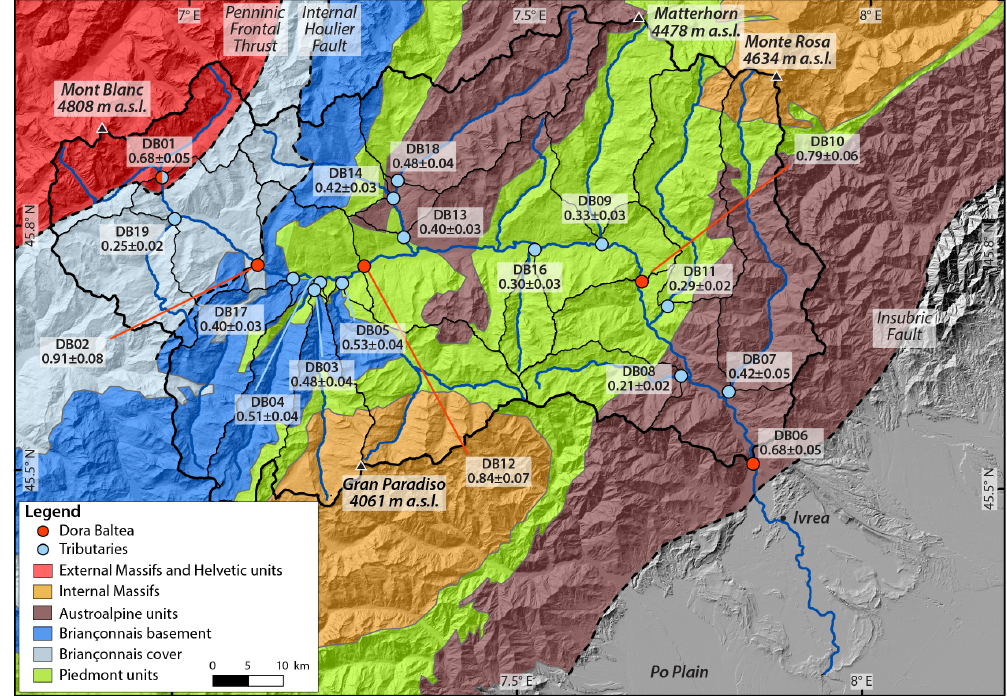
Figure 2. Simplified lithotectonic map of the study area with output catchment-wide denudation rates ( ± 1 σ ,mmyr − 1 ) reported at sampling locations (catchment boundaries in solid black lines). Major lithotectonic domains and structural features (dashed lines) of the western European Alps are shown (modified map after Resentini and Malusà, 2012). Output catchment-wide denudation rates are corrected for topographic, LIA glacier and snow shielding, as well as for quartz content (see text and Table 1 for details).